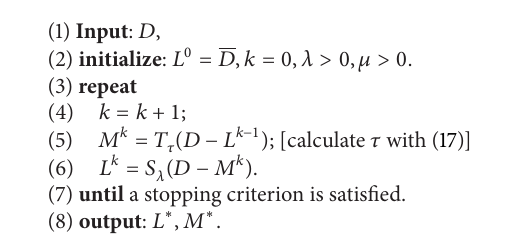
Algorithm 1: Solving dual norm model NSMP with AIM.